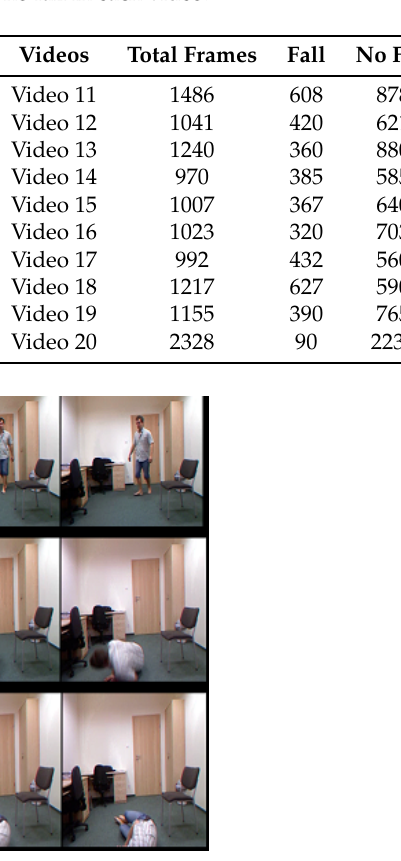
Table 1. Details of the Multiple Cameras Fall (MCF) Dataset: total number of frames, number of frames containing a fall, and number of frames containing no fall in each video.